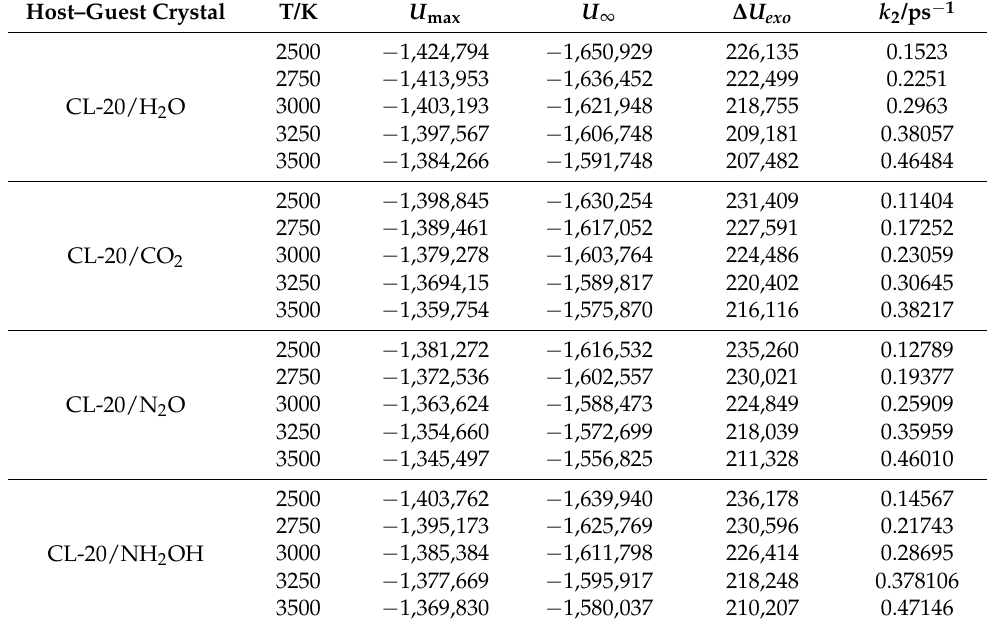
Table 3. Partial parameters of PE curve attenuation